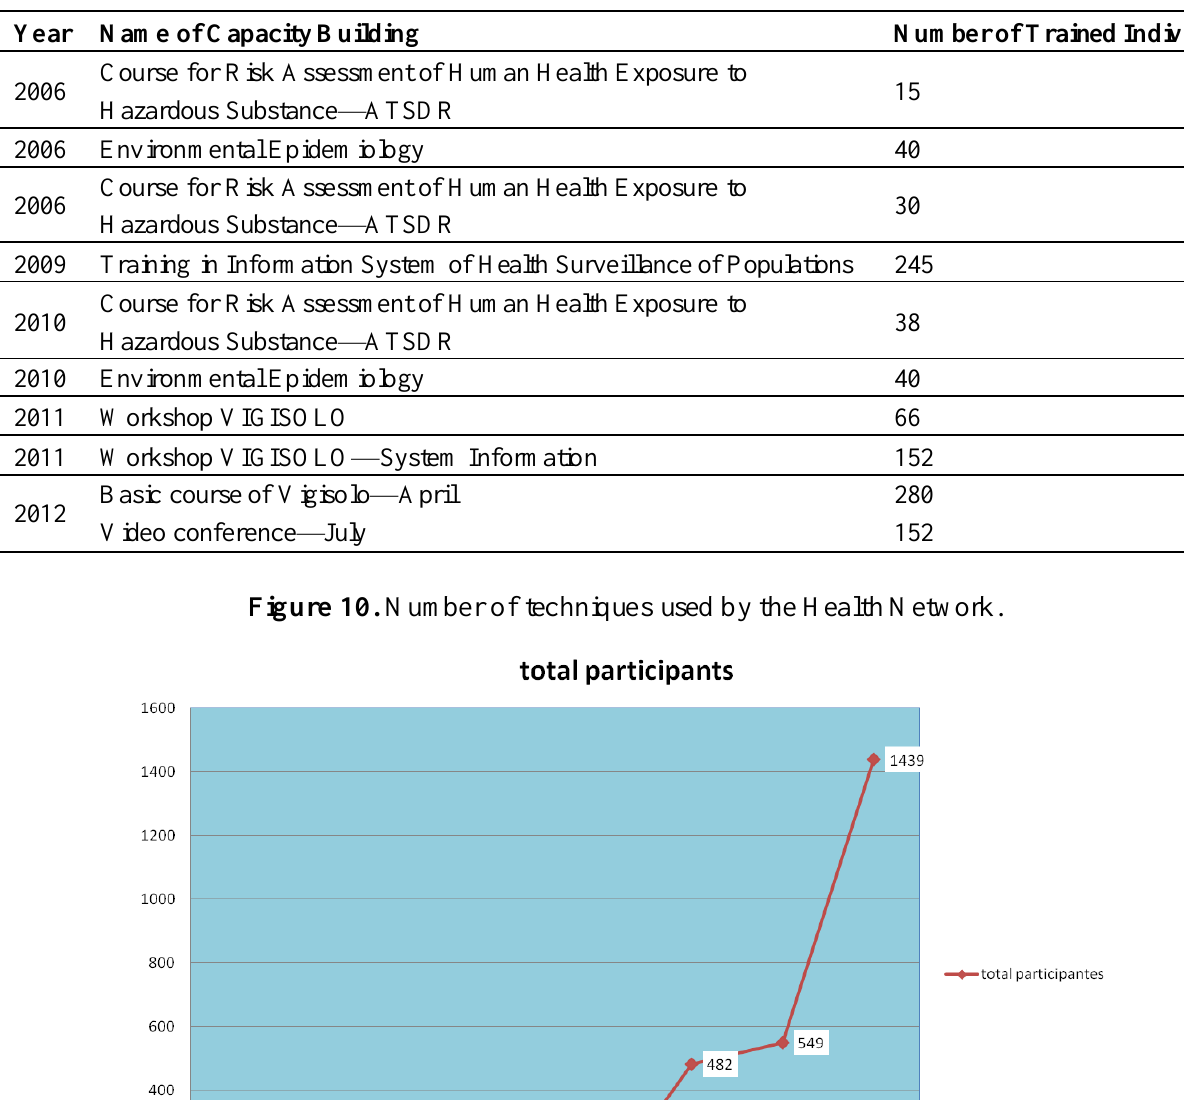
Table 2. Training held to the Health Technicians 2006–2012.